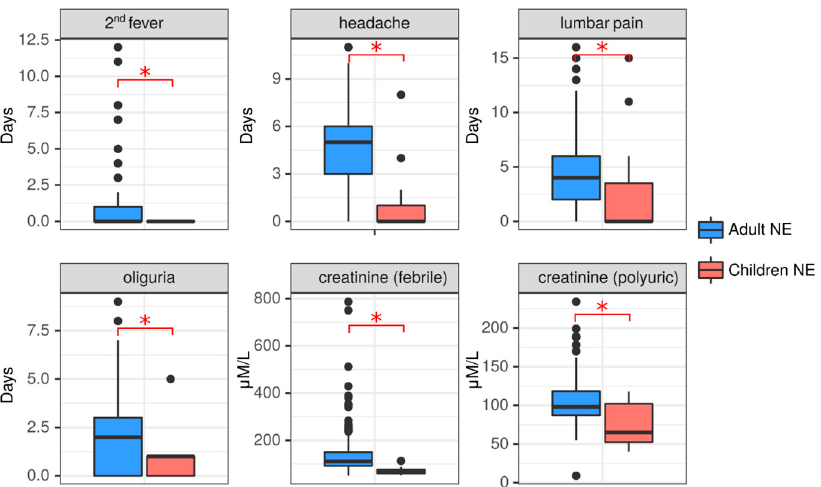
Figure 3. Clinical comparison of NE in adults and children. Duration of the symptoms 2nd fever, headache, lumbar pain and oliguria were recorded in both adult (blue) and child (red) NE patients. Serum creatine levels at the febrile and polyuric phases were also compared between adults (blue) and children (red) with NE. Data is presented as boxplotwith asterisks denoting statistical significance between adults and children as determined by Kruskal-Wallis test ( p < 0.05).